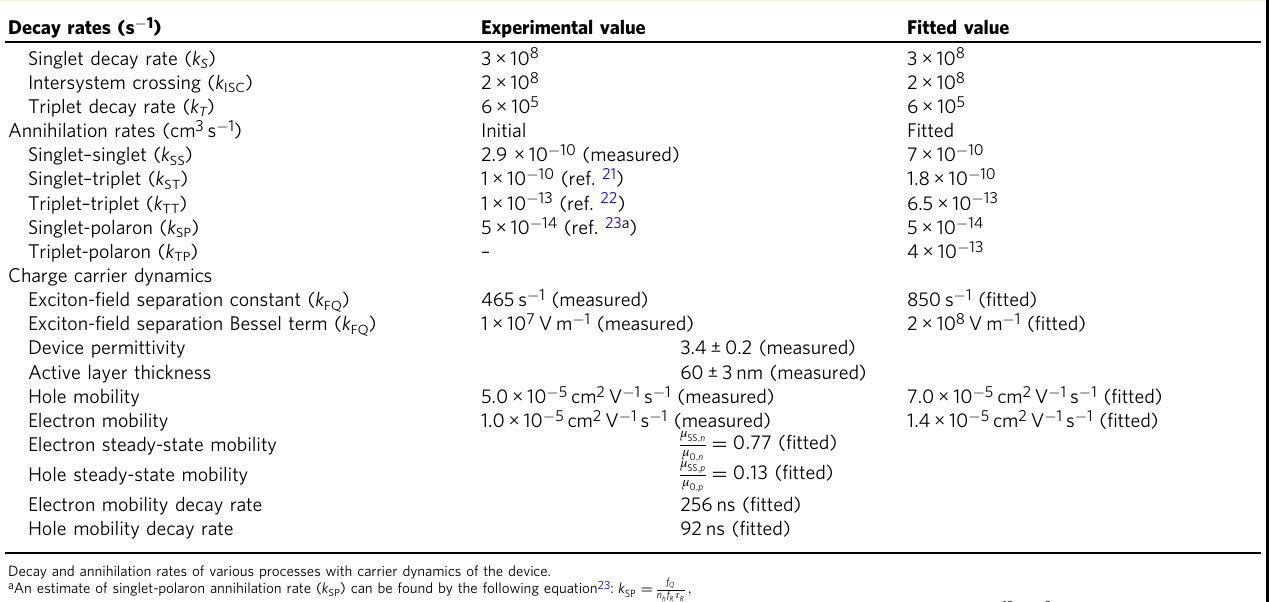
and it is necessary to account for singlet-polaron annihilation (SPA) given by rate ( k SPA ), triplet-polaron annihilation (TPA) given by rate ( k TPA ) and fi eld quenching 16 ( k FQ ) processes. The rate constants for fi eld quenching 16 , singlet-polaron and triplet- polaron quenching were measured using fi eld-dependent PL